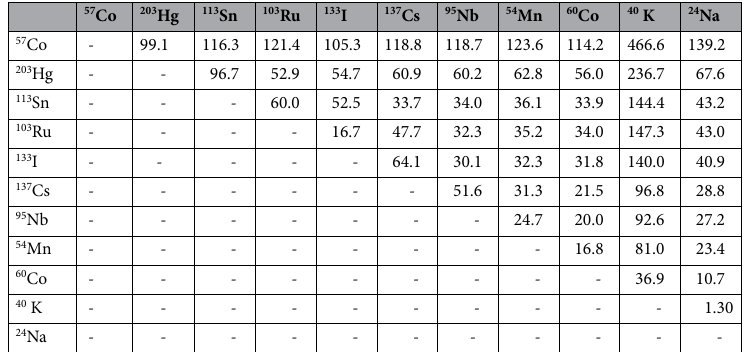
Table 4. Lower limit of simultaneously identified relative distances of gamma sources by considering equal activities (considering branching ratios) from gamma finder (lower energy source is fixed in distance of 4.0 m). “ ∀ ” means no matter where S 1 ( E 1 > E 2 ) is located, if S 2 is located in distance of 4.0 m from detector, it will be recognizable and “†” indicates that S